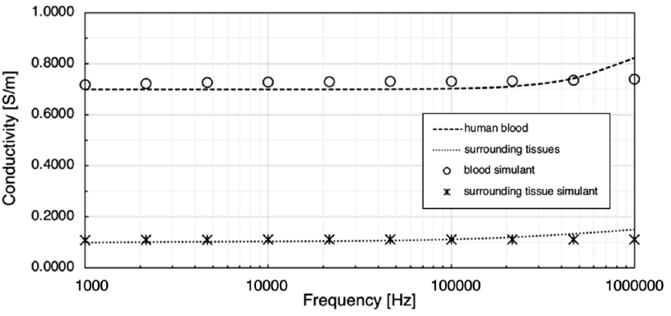
Figure 14. Comparison between prepared tissue simulants and target